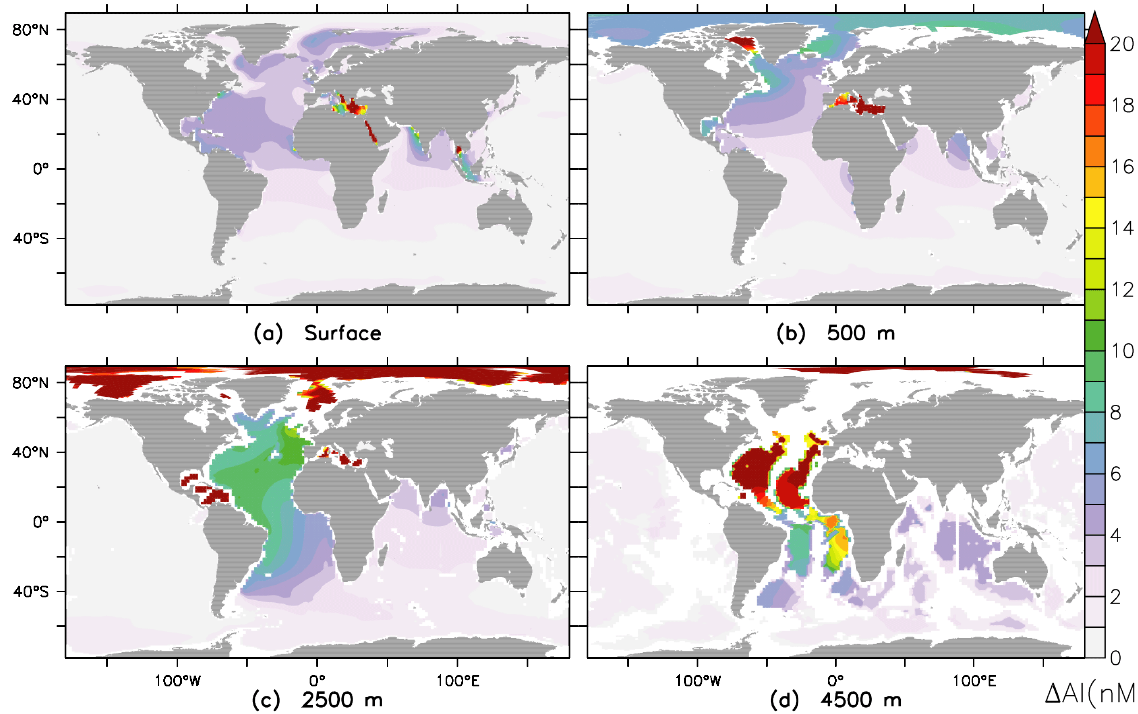
Figure 9. Difference of [ Al diss ] (nM) between the simulation with [ Si diss ] -dependent sediment resuspension (SedMackin) and the reference simulation at four depths (500 yr after